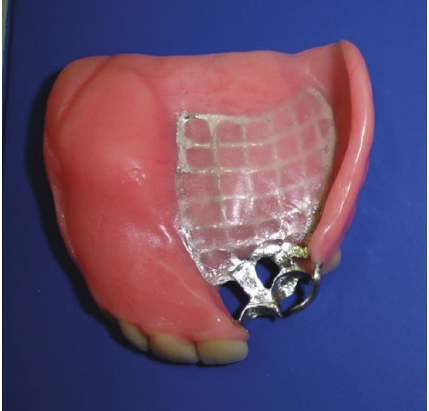
Figure 7: Obturator